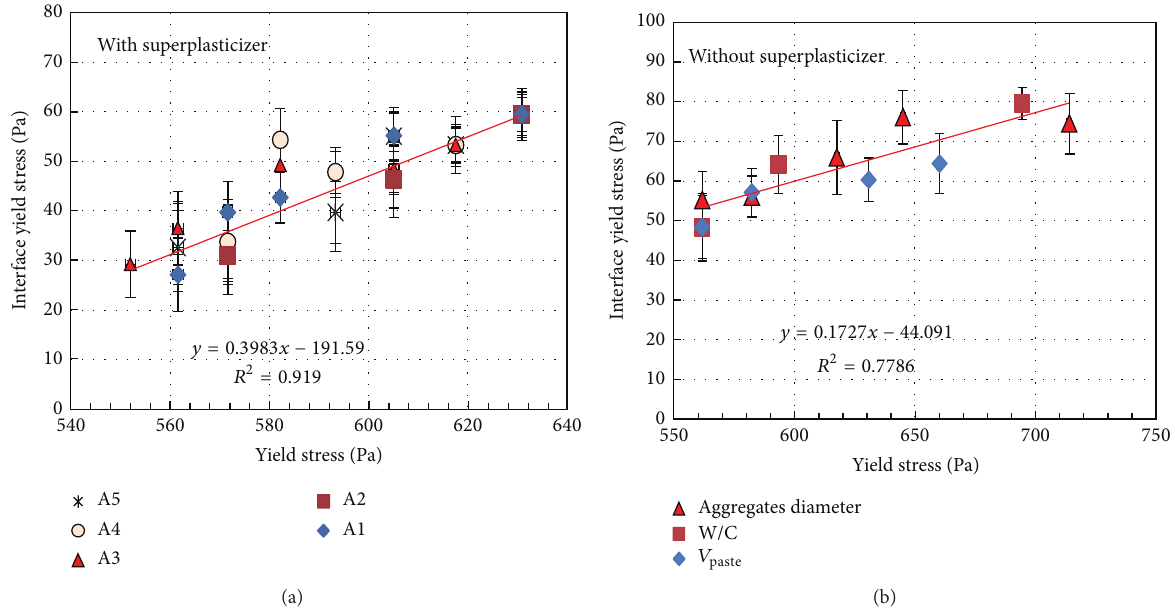
Figure 10: Evolution of the interface yield stress 𝜏 0𝑡 according to the concrete yield stress 𝜏 0 calculated by (11): (a) concretes series without superplasticizer and (b) concretes series with superplasticizer.